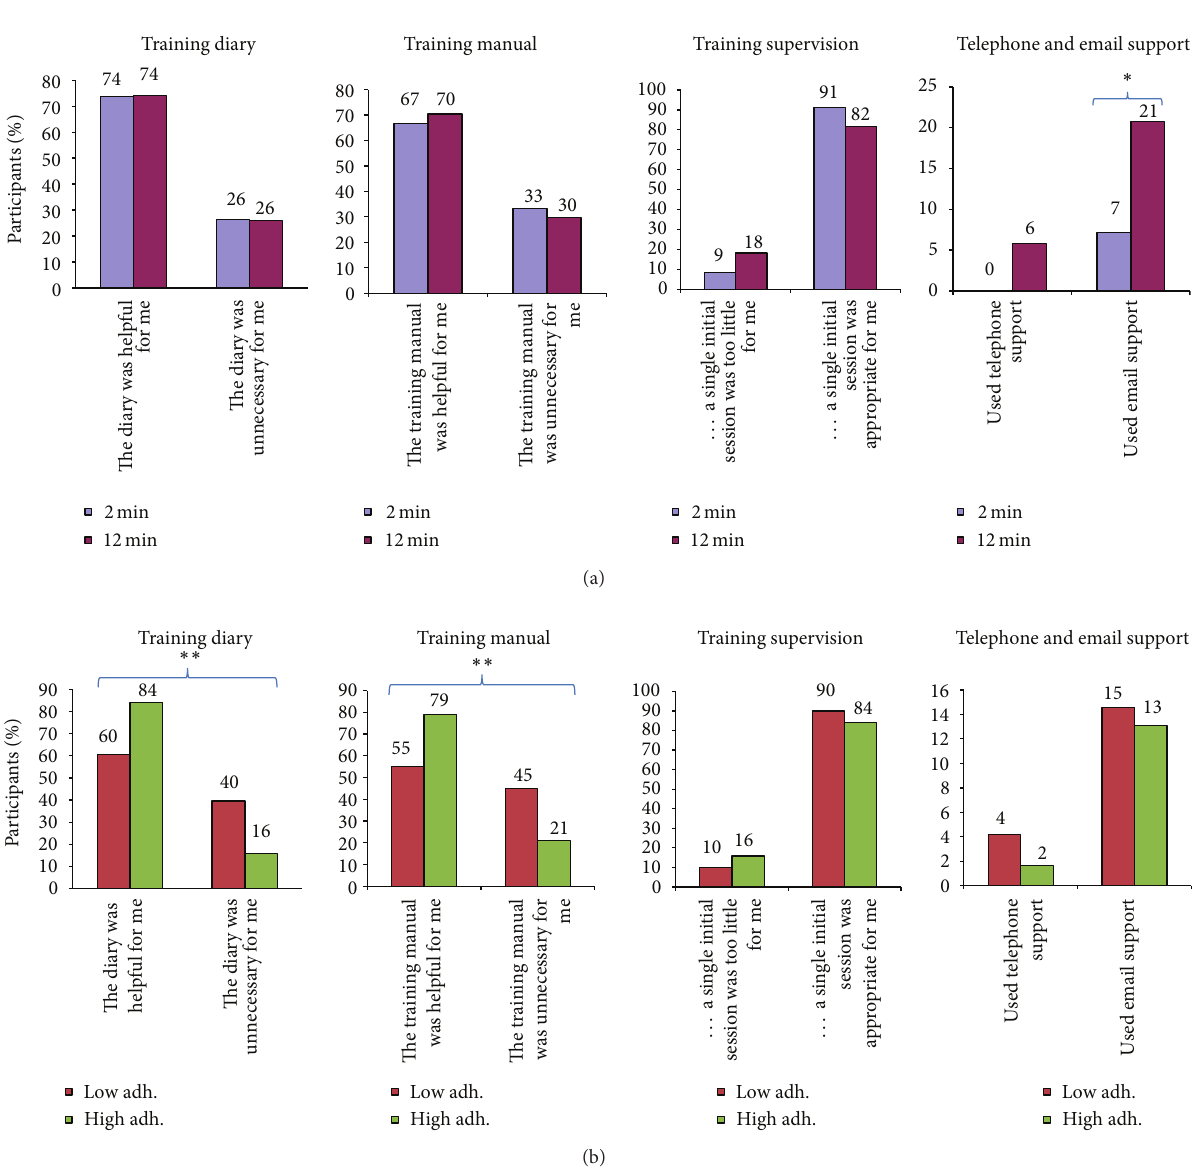
Figure 4: (a) Follow-up questionnaire (satisfaction, barriers, and facilitators). Participant feedback on supportive elements related to the trainingprogram, thatis,thetrainingdiary(1stpanel), trainingmanual (2ndpanel), training supervision(3rdpanel), and telephone andemail support (4th panel) in the 2 and 12 min groups. (b) Follow-up questionnaire (satisfaction, barriers, and facilitators). Participant feedback on supportive elements related to the training program, that is, the training diary (1st panel), training manual (2nd panel), training supervision (3rd panel), and telephone and email support (4th panel) among those with low and high adherence. ∗∗ Significant difference (Fisher’s exact test, 𝑃 < 0.01